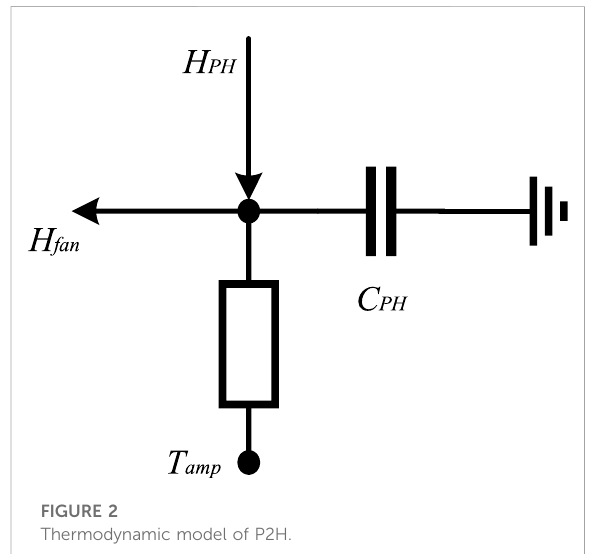
FIGURE 2 Thermodynamic model of